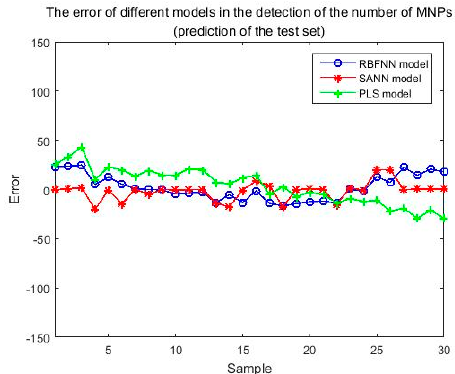
Figure 20. Comparison of the prediction errors of different MNPs number detection models (the test set).